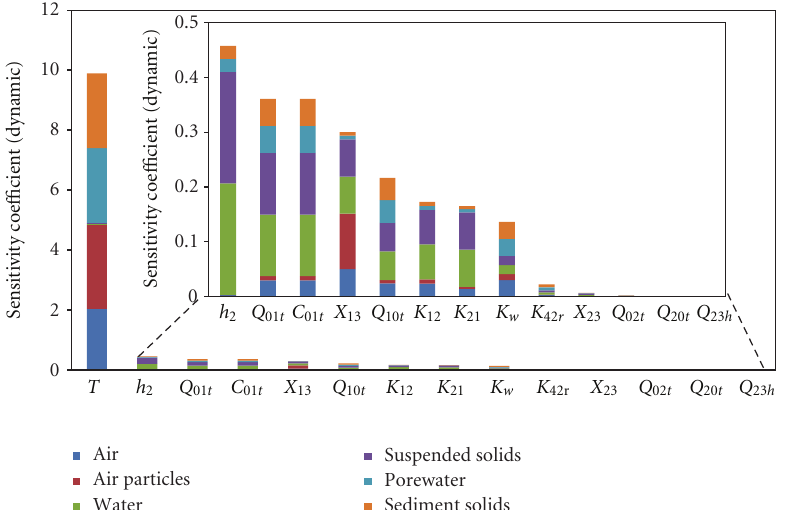
Figure 7: Dynamic coe ffi cients of sensitivity of the calculated concentrations of the environmental compartments to the input dynamic